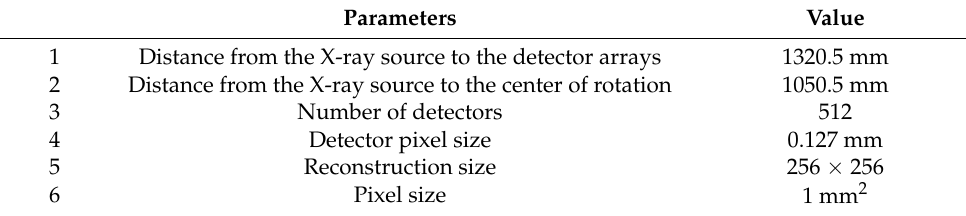
Table 1. Data acquisition